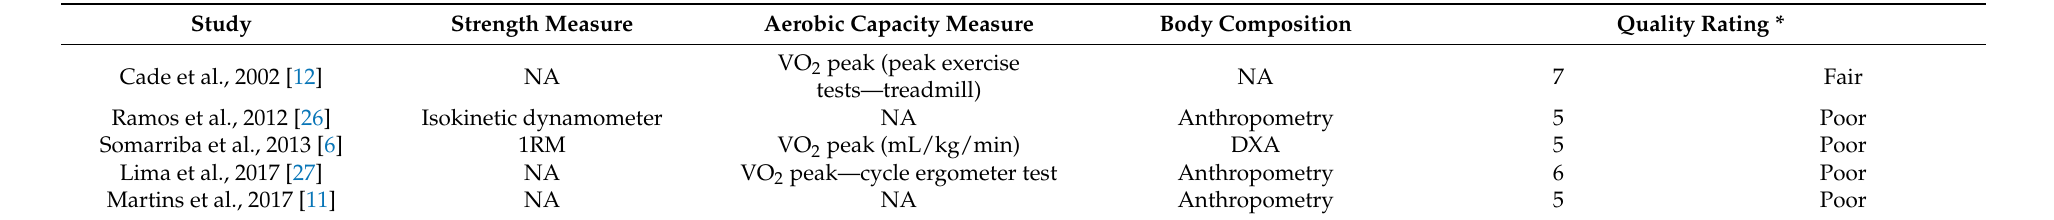
Table 2. Cont. characteristics of the studies included in the